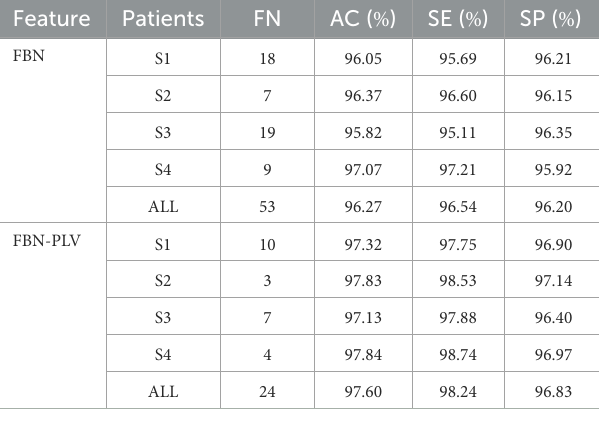
TABLE 3 Model performance comparison between FBN and FBN-PLV.